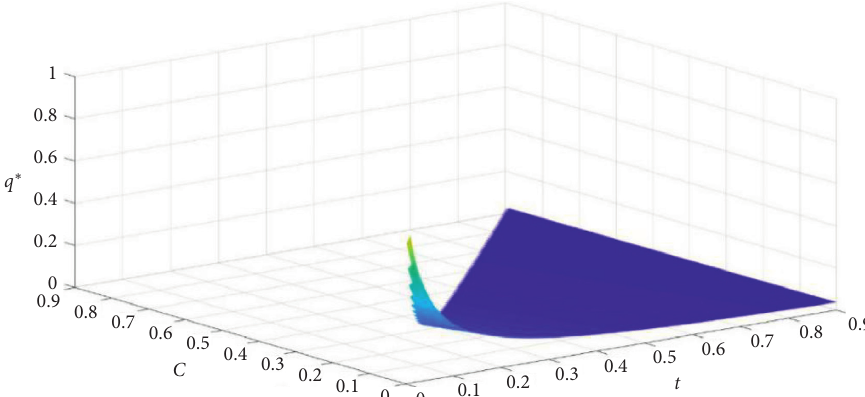
Figure 1: Simulation diagram of the influence of maximum rent-seeking revenue and rent-seeking cost on the optimal rent-seeking probability q ∗ of private enterprises.